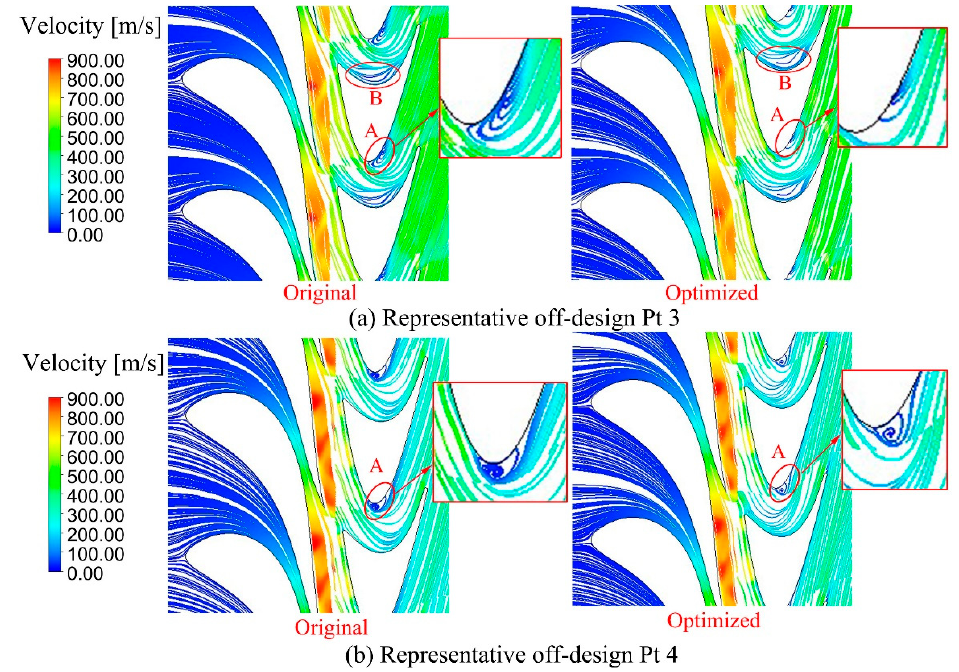
Figure 14. Streamline of original and optimized turbine at 50% span.